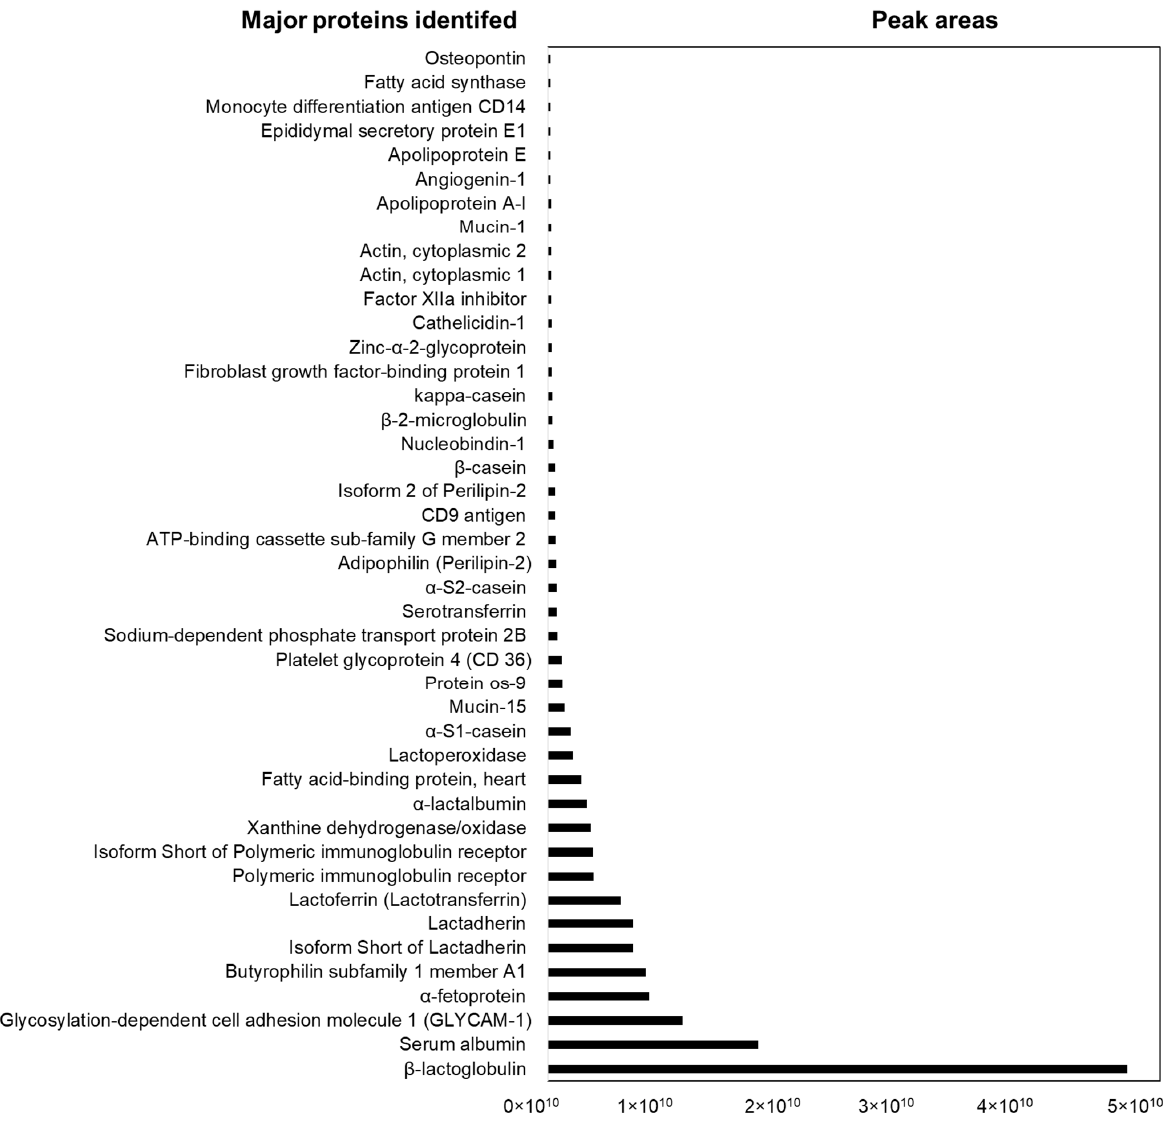
Figure 3. Relative abundance of major proteins identified in WPPC by proteomics.